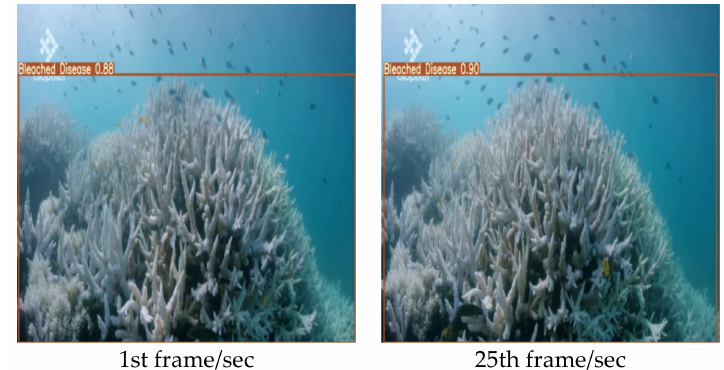
Figure 32. Snapshot of video inference on NVIDIA Jetson Xavier NX